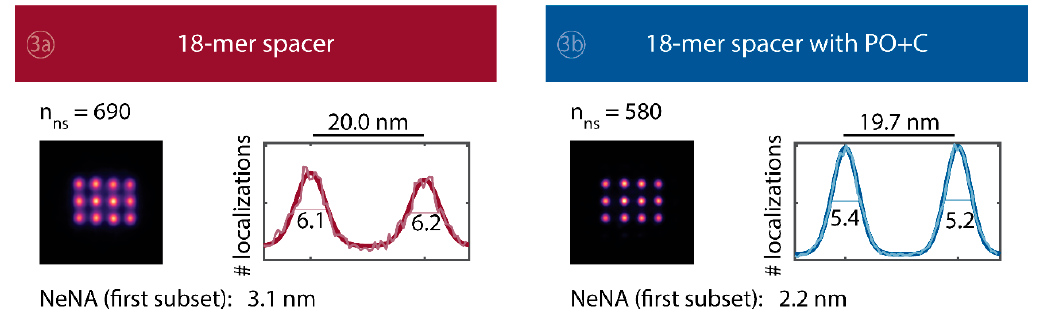
Figure A4. Averaged super-resolved DNA-PAINT images of DNA origami nanostructures for the whole time series of 83 min. The total numbers of identified DNA origami nanostructures n ns employed for averaging are stated above the average images. Line profiles of total number of localizations through the two lower left points from each averaged image were fitted with a double Gaussian function (cid:3118) ((cid:3051)(cid:2879)(cid:3029) (cid:3117) ) (cid:3118) (cid:4672)𝑓(𝑥) = 𝑎 (cid:4675) + 𝑎 (cid:2870) exp(cid:4674) ((cid:3051)(cid:2879)(cid:3029) (cid:3118) ) (cid:4675) + 𝑐(cid:4673) . The number stated for each peak is the FWHM (in nm) and can be interpreted as a measure of the achievable resolution; the peak-to-peak distance is shown above the plot. Additionally, the value of the nearest neighbor analysis (NeNA) [11,75] is shown for the first subset.